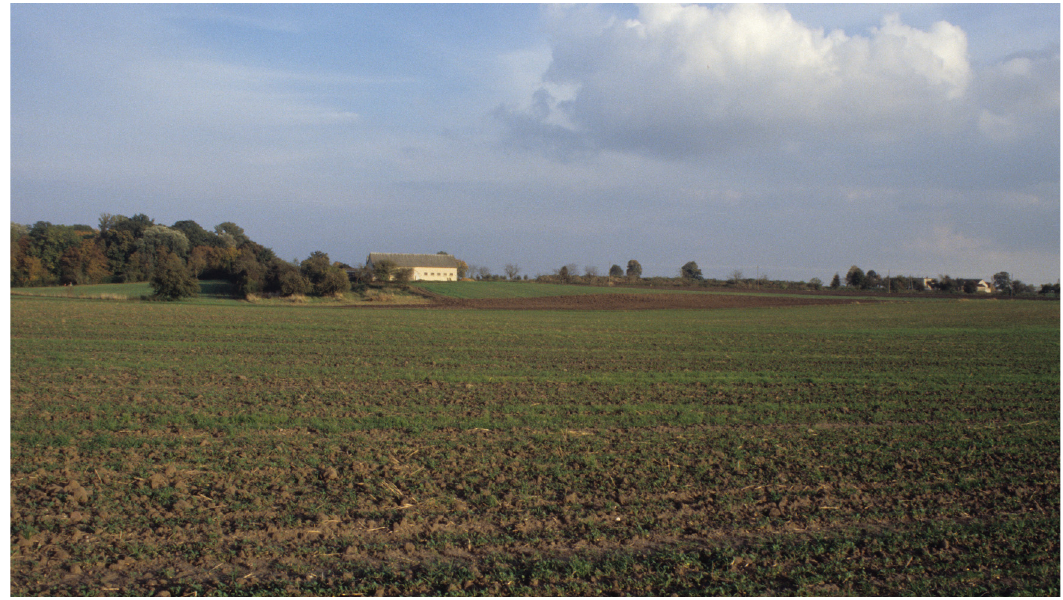
Figure 6: Kuyavian landscape near Ludwinowo. Photo: J.